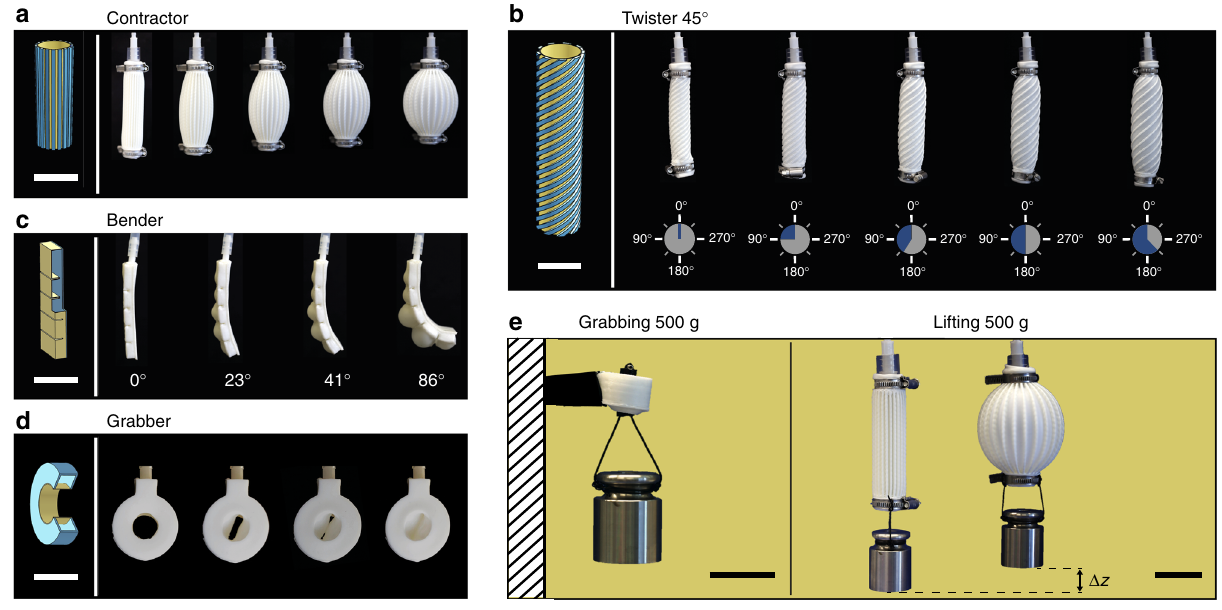
Fig. 3 Soft actuators with programmed motion modes fabricated by multimaterial 3D printing of silicones. Actuators with bioinspired architectures are shown in a and b , whereas other multimaterial morphing con fi gurations are displayed in c and d . a Contraction is achieved by printing stiff stripes along the long axis of a soft silicone tube (lead angle α = 0°), thereby restricting its elongation and only allowing for radial expansion. b A twisting motion is generated by winding the stripes around the soft inner tube with a lead angle of for example 45° with respect to the long axis. The twisting angle increases with the applied internal pressure. c Bending motion is obtained when a soft silicone with embedded air cavities is printed onto a stiff silicone fi lm, restricting one side of the chambers from expansion when pressurized. Bending angles up to 90° are achieved at a pressure of 6 kPa. d A grabbing and sealing soft actuator was designed by printing a closed, stiff silicone cylinder with a concentric inner soft tube separated by an air cavity. When in fl ated, the inner tube deforms uniformly until mechanical instability leads to buckling and fi nally to a complete sealing of the central opening. e Load bearing capacity of grabbing and contractile soft actuators. Scale bars are 2 cm for a – d and 4 cm for